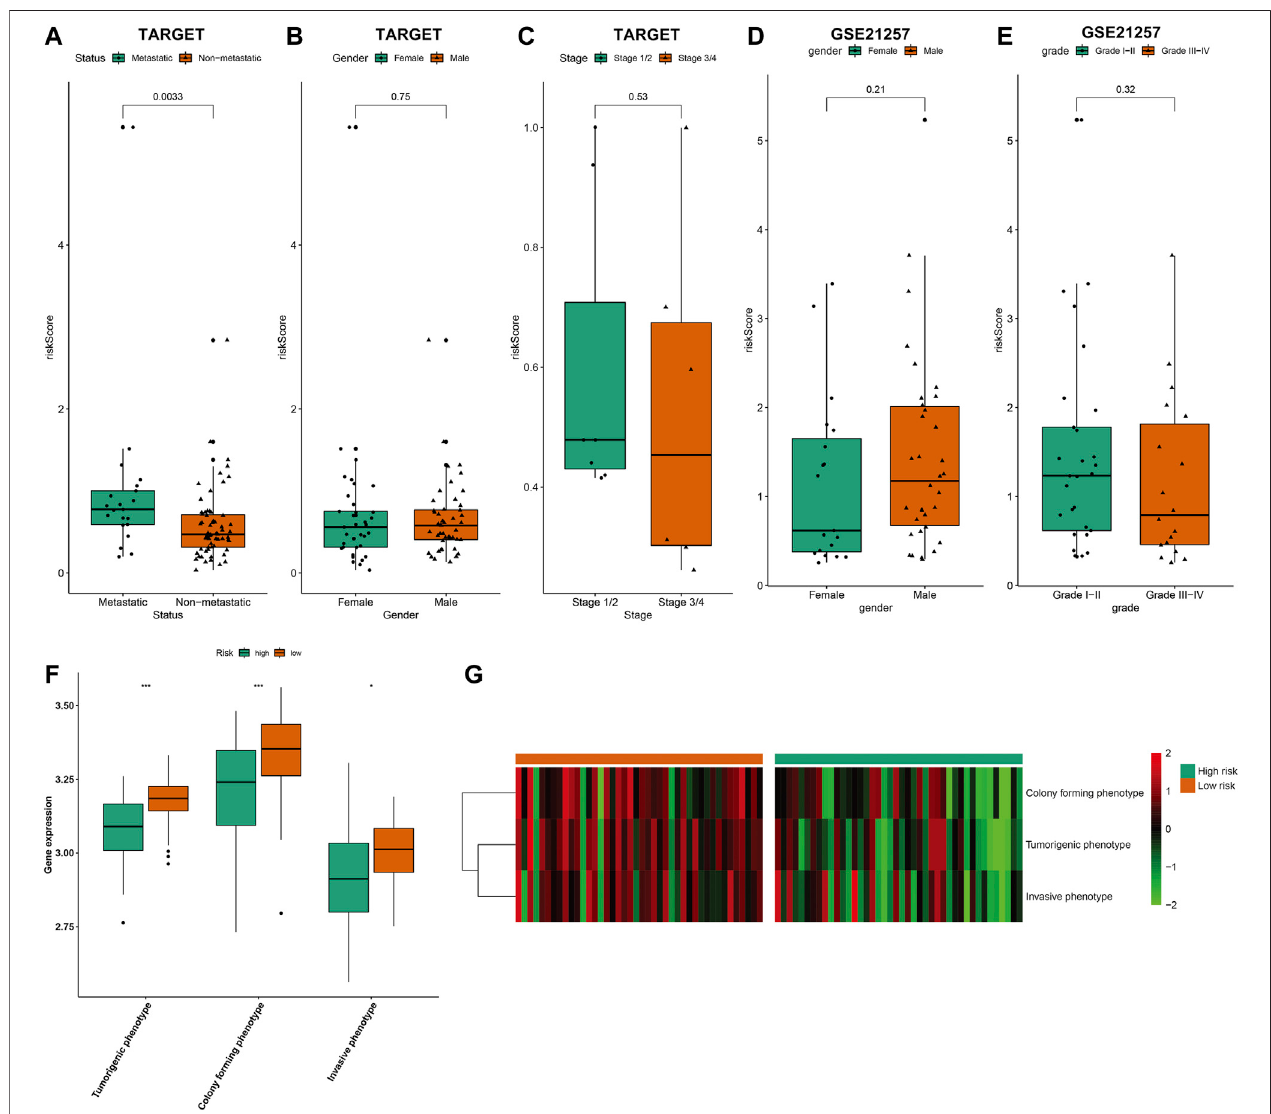
FIGURE7| Associationsbetweenriskscoresand clinicopathological characteristicsand phenotypes ofosteosarcoma celllines. (A – C) Comparisons ofriskscore (A) between metastatic and non-metastatic patients; (B) between female and male patients; (C) between stage 1/2 and stage 3/4 patients in the TARGET cohort. (D,E) Comparisons of risk score (D) between female and male patients; (E) between grades I – II and grades III – IV patients in the GSE21257 dataset. (F,G) Comparisons of threephenotypesofosteosarcomacelllines(tumorigenicphenotype,invasivephenotype,andcolonyformingphenotype)betweenhigh-andlow-riskgroupsusing ssGSEA method in the TARGET cohort. * p < 0.05; *** p < 0.001.